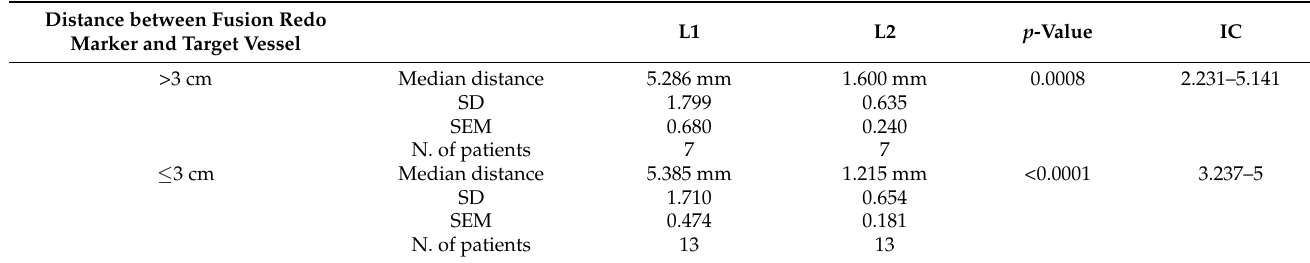
Table 5. Analysis of accuracy of measurement over two patient subgroups.